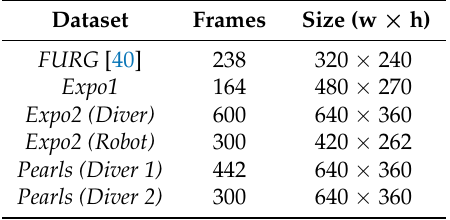
Figure 8. Examples of the images contained in each dataset. In the case of Pearls and Expo2 dataset we show images from the same place taken by the different agents (in the same row). Table 1. Information about the datasets utilized for